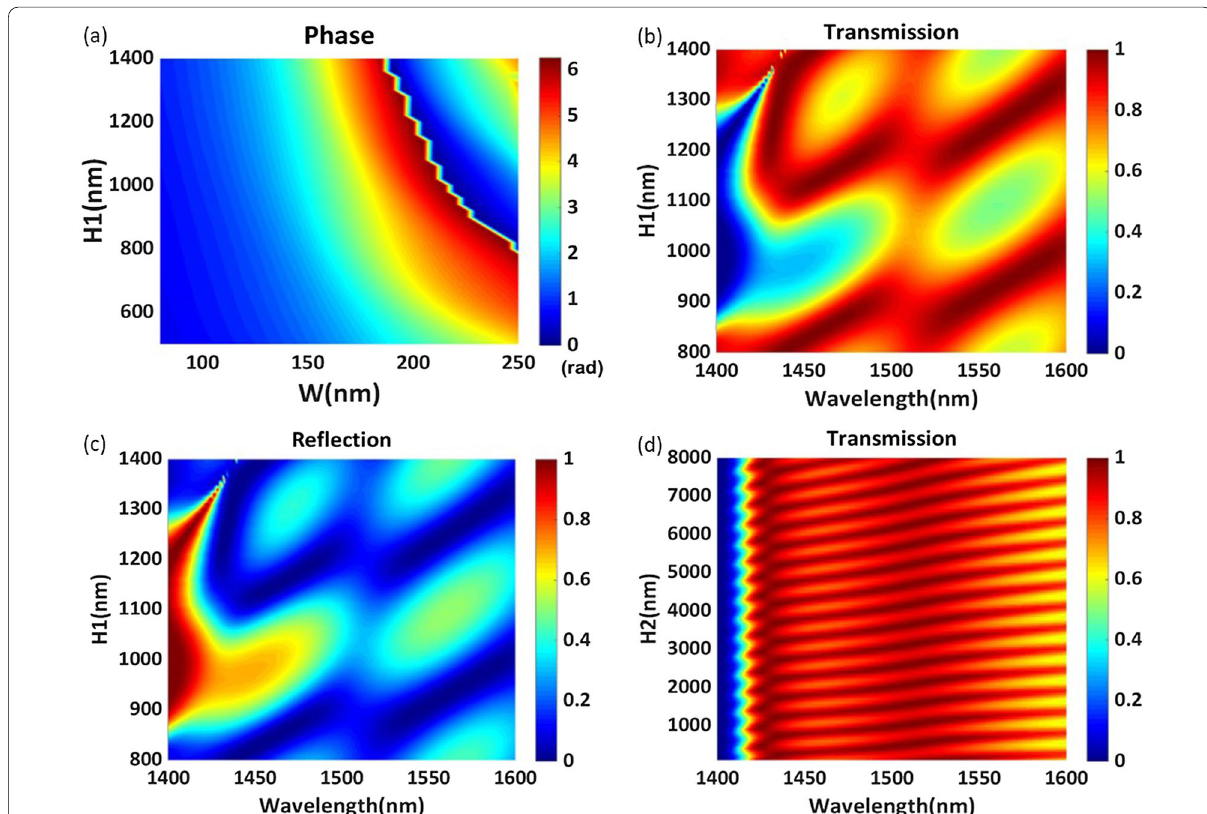
Fig. 2 a Phase of the periodic regular hexagonal nanorods for different structural parameters H 1 and w at a wavelength of 1529 nm. b The transmission efficiency and c the reflection efficiency of the periodic structure for different thicknesses H 1 in the wavelength range of 1400–1600 nm. d Transmission efficiency of the periodic structure for different thicknesses H 2 in the wavelength range of 1400–1600